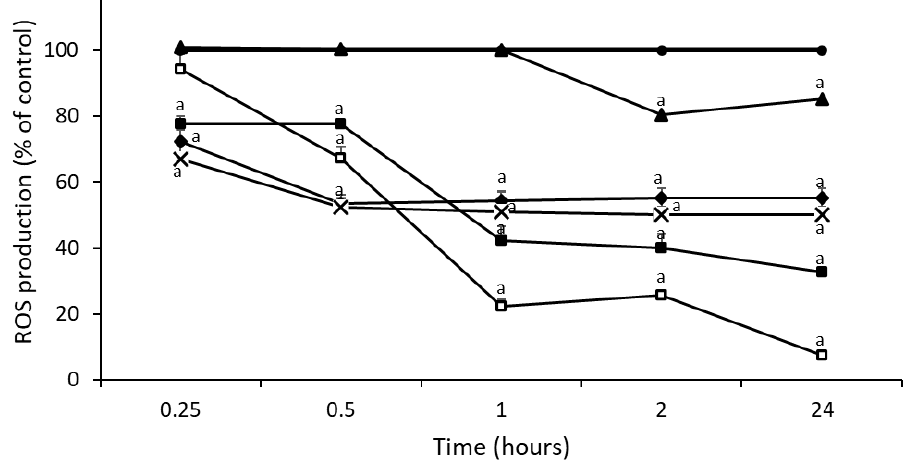
Figure 3. Time course of ROS production in untreated HepG2 cells ( ● ) and treated with NAC ( ■ ), sample 7 (CH + 2RJ) ( ▲ ), sample 8 (CH + 10RJ) ( ◆ ), sample 9 (CH + 2PR) (X), and sample 10 (CH + 10PR) ( □ ). Significant difference from control a p < 0.05.